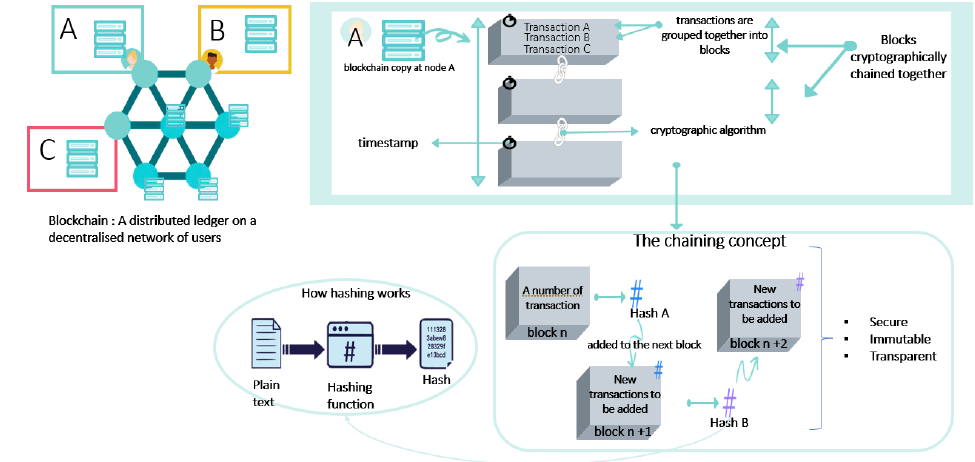
Figure 3. Blockchain concepts elaboration by the